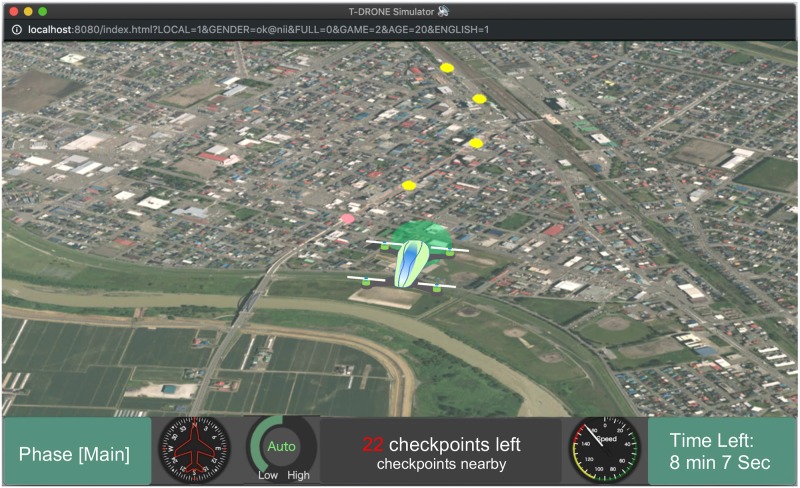
Online drone simulator.Operating the simulator was relatively easy, with two cursor keys for controlling the direction of the drone and mouse buttons for making choices. Geospatial Information Authority of Japan (https://maps.gsi.go.jp) CC BY 4.0. The image is similar but not identical to the original one used in the experiment due to a copyright reason.